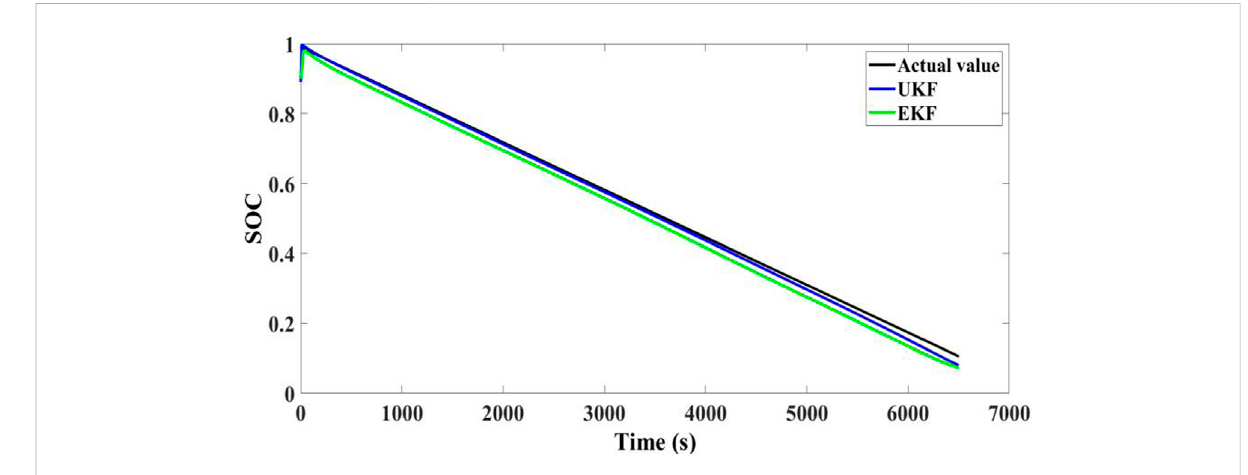
FIGURE 6 SOC estimate results under constant current condition.